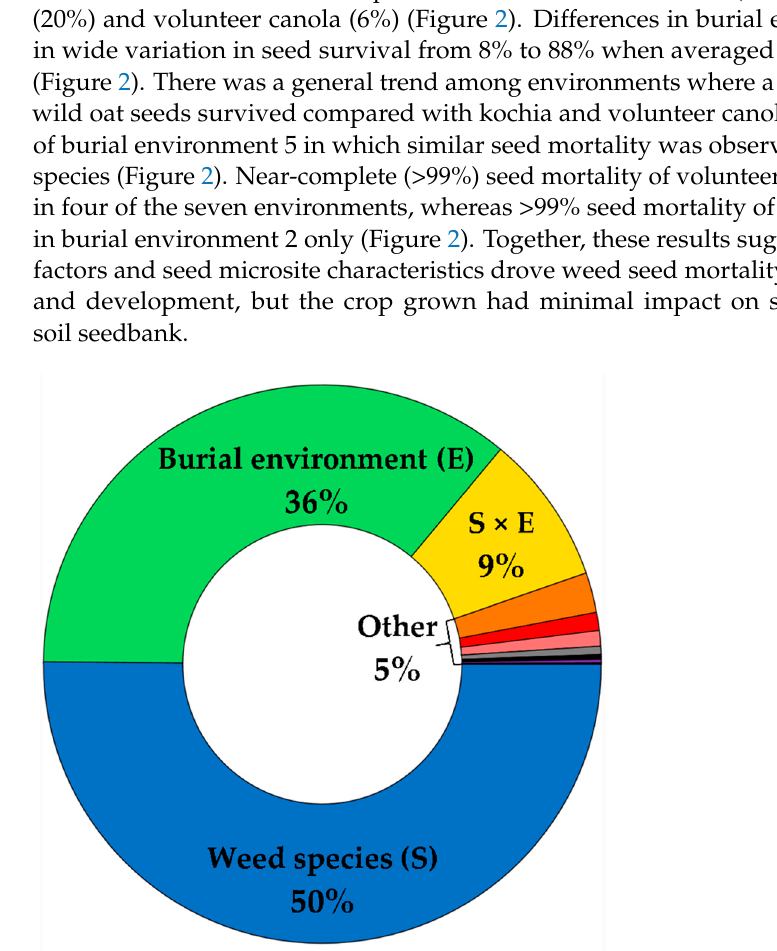
Figure 2. The percentage of volunteer canola, kochia, and wild oat seeds that survived a 7 week burial period in seven different environments planted to wheat, canola, and field pea (n = 9). Bars indicate back transformed arcsine square root means among crop species. Different letters indicate significant difference based on Tukey’s HSD ( α = 0.05). 3.2. Contribution of Soil Edaphic Factors and Seed Microsite Characteristics